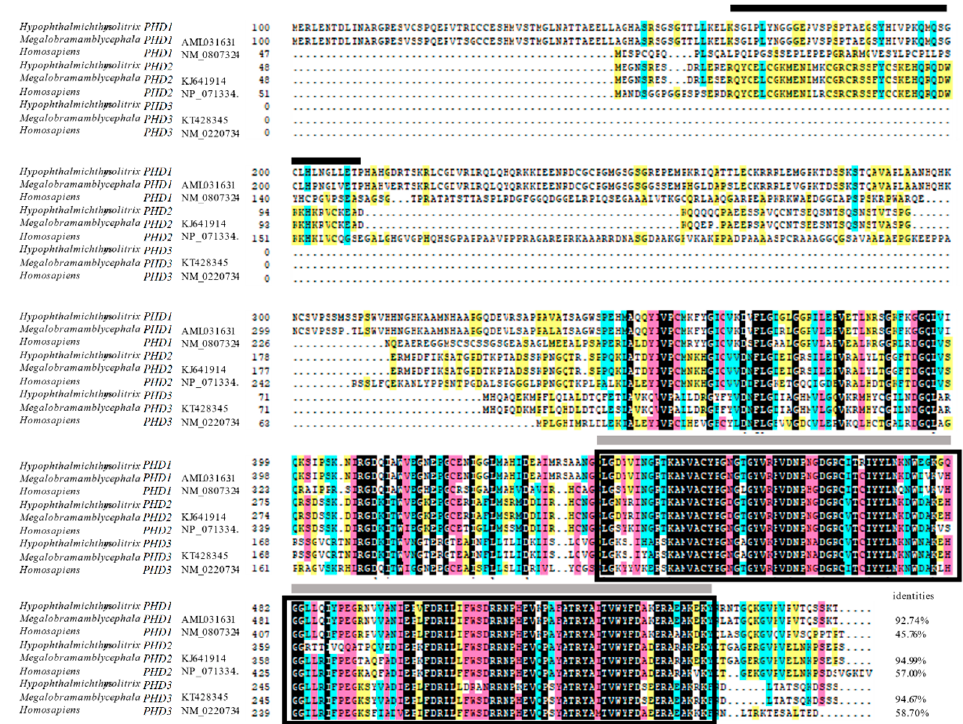
Figure 1. Alignment of H. molitrix PHDs deduced aa sequences with M. amblycephala and Homo sapiens . The GenBank accession numbers are indicated on the left of the alignment. The MYND-type zinc finger domain is included as a black straight line. The P4Hc homology region is included as an open box. The 2OG-Fe dioxygenase domain is included as a gray straight line.